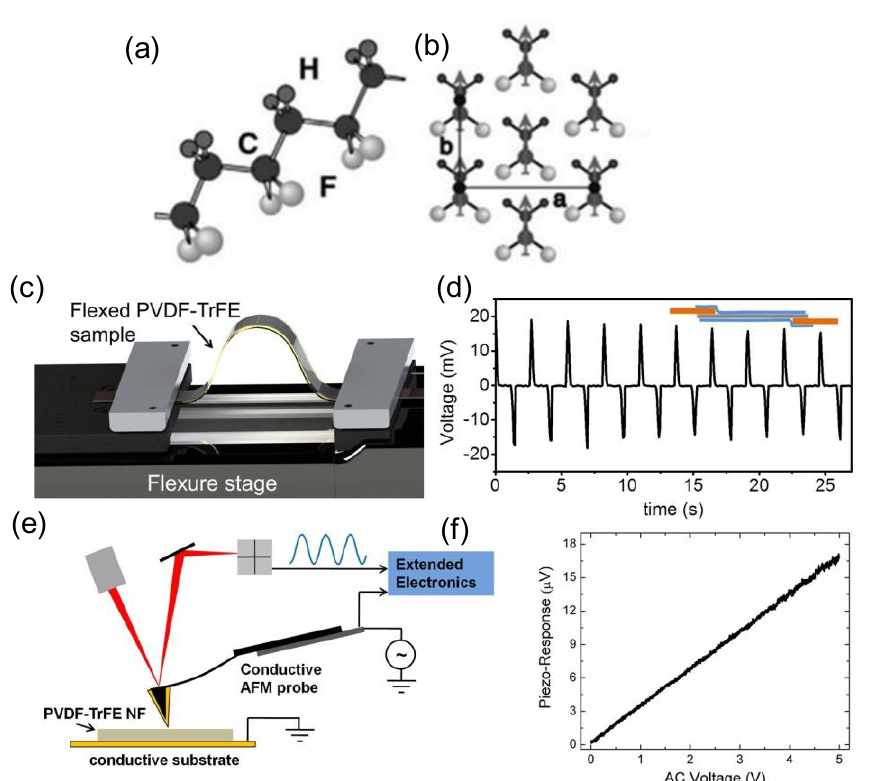
Figure 5. ( a ) Chain structure PVDF in the all − trans conformations, which exhibits the planar carbon backbone with coupled F and H atoms, and ( b ) the crystal structure of the phase. In this figure, a and b represent the parallel alignment of the junction axes and the direction of polarization, respectively. Reproduced with permission [43]. Copyright 2023, Royal Society of Chemistry. ( c ) Piezoelectric characterization of the electro − spun nanofibers. ( d ) Flexure test experiment. Plot depicts the generated voltage for a number of flexed and unflexed states; inset shows a schematic of the ready sample. (e) PFM experimental schematic of PVDF−TrFE nanofiber and (f) its piezo−response amplitude vs. applied voltage. Reproduced with permission [44] . Copyright 2015, American Chemical Society.